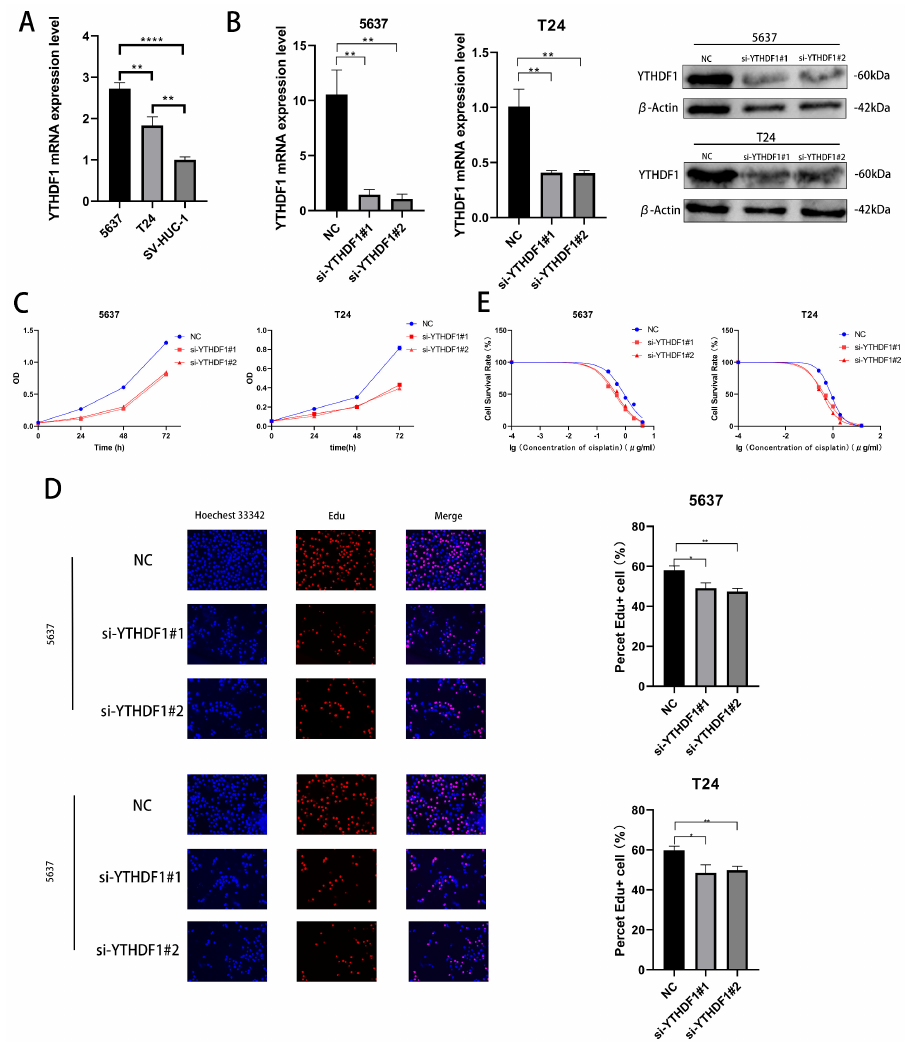
Figure 2. YTHDF1 affects the proliferation and cisplatin sensitivity of BLCA cells. ( A ) Validation of YTHDF1 mRNA expression in 5637, T24 and SV-HUC-1 cells. ( B ) YTHDF1 mRNA and protein lev- els were knocked down in T24 and 5637 cells. ( C , D ) EdU and CCK-8 proliferation assays were per- formed to verify the effect of YTHDF1 on the proliferative capacity of BLCA cells. ( E ) MTT assay to verify the effect of YTHDF1 on the cisplatin sensitivity of BLCA cells. * p < 0.05, ** p < 0.01, **** p < 0.0001 or not significant (ns).